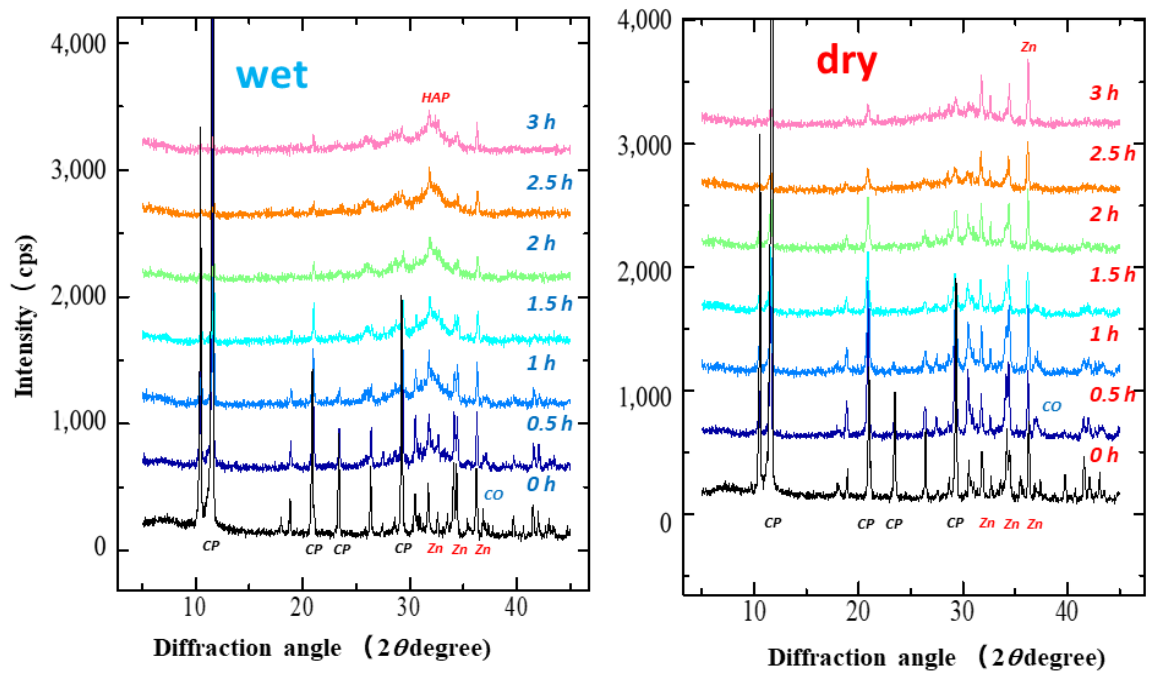
Figure 1. X-ray diffraction (XRD) patterns of S-CP containing CHPD (CP), CaO (CO), and ZnO (Zn) (20:7:3) during wet or dry grinding conditions. Left: wet grinding; right: dry grinding. Left is wet grinding; right is dry grinding. The powder X-ray diffraction pattern of CHPD was identified as “Brushite” (CaHPO 4 · 2H 2 O) PDF#00-009-0077 (RDB) by the Powder Diffraction File TM system in In- ternational Centre for Diffraction DATA, https://www.icdd.com/pdf-4-web/ (accessed 8 May 2022).